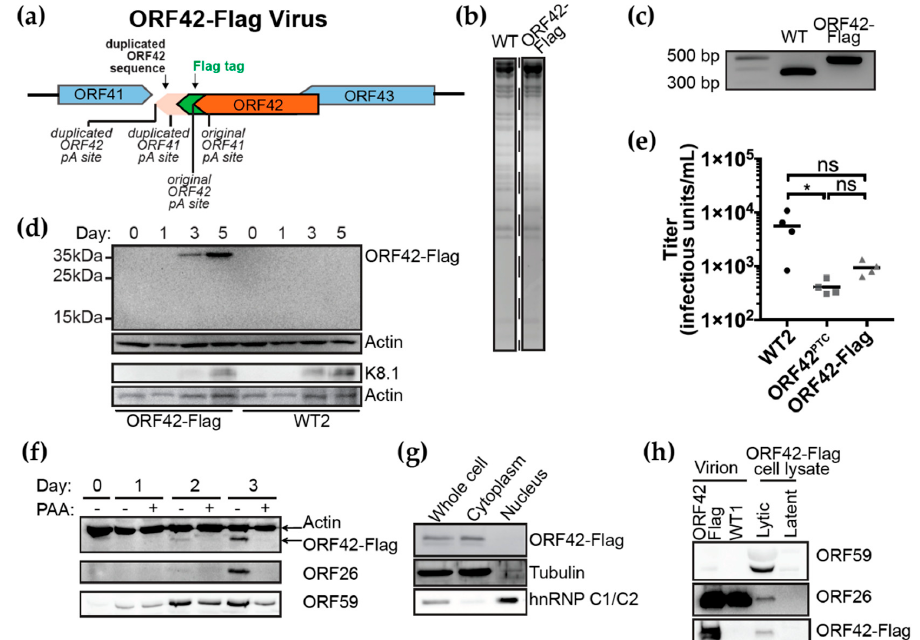
Figure 3. ORF42 is a late cytoplasmic protein. ( a ) Schematic diagram of the KSHV ORF42-Flag genome structure, indicating the C-terminal Flag tag position and the partial duplication of ORF42 sequences, including the original and duplicated ORF41 and ORF42 polyadenylation (pA) sites. ( b ) WT and ORF42-Flag BACs were digested with the KpnI restriction enzyme and resolved on a 0.4% agarose gel. ( c ) The modified region of the ORF42-Flag BAC16 was PCR amplified and resolved on a 1.5% agarose gel to confirm the presence of the insertion. ( d ) Protein lysates were collected at the indicated time points (day = days post-induction) from cells infected with WT KSHV or KSHV ORF42-Flag infected cells. ORF42 was detected using anti-Flag antibodies. Actin serves as a loading control and K8.1 as a control for lytic reactivation. ( e ) Supernatant was collected 6 days post-induction from cells infected with KSHV WT, ORF42 PTC or ORF42-Flag and used to infect HEK293T target cells. Infectious titers were calculated from the percentage of GFP-positive target cells determined by flow cytometry. Lines indicate median titers. ns, * = p > 0.05 and < 0.05, respectively. ANOVA followed by Tukey’s multiple comparison test. ( f ) Protein lysates were collected at the indicated time points from cells infected with KSHV ORF42-Flag and treated with doxycycline and the viral DNA polymerase inhibitor phosphonoacetic acid (PAA, 100 μ g/mL). They were then analyzed by Western blot. Antibodies detecting ORF42-Flag, actin as a loading control, and ORF59 and ORF26 as representative early and late viral proteins were used. ( g ) Cells infected with KSHV ORF42-Flag were fractionated into cytoplasmic and nuclear fractions at Day 4 post-induction. Lysates were stained for ORF42-Flag, and tubulin and hnRNP C1 / C2 as cytoplasmic and nuclear loading controls, respectively. ( h ) Six days post-induction, virions were isolated from the supernatant of cells infected with WT KSHV or KSHV ORF42-Flag and lysed to collect protein. Lysates from latent and lytic KSHV ORF42-Flag-infected cells are shown as staining controls. Western blotting was used to detect ORF42-Flag, ORF59 (polymerase processivity factor) and ORF26 (capsid protein). All blots are representative of ≥ 3 biological